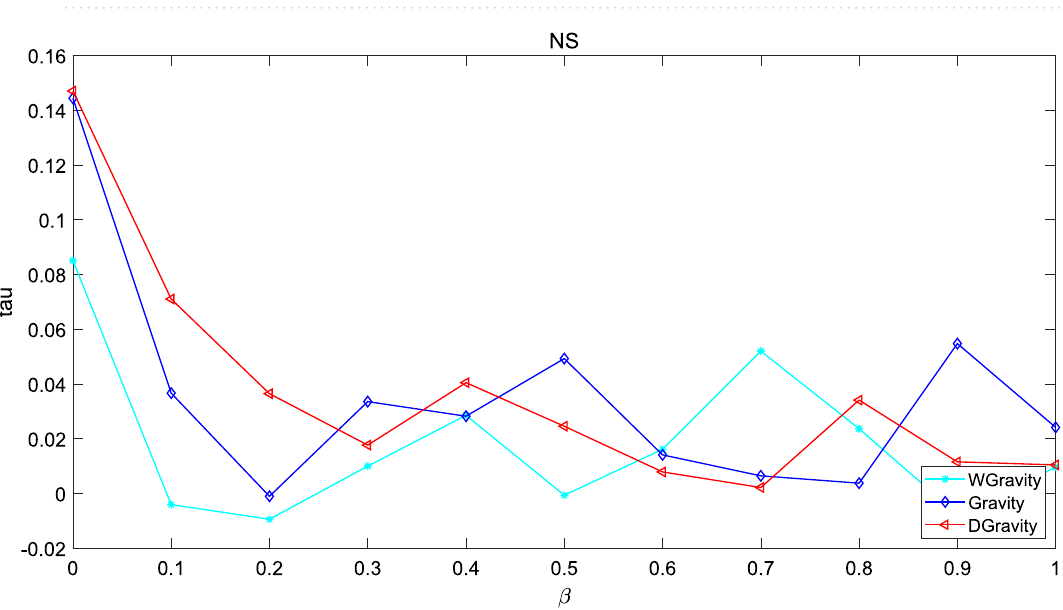
Figure 16. This figure describes the correlation between the methods based on gravity model and the standard sequence generated by SI in NS. The performance of the new model is better in the early stage, and the performance of the three methods is close to the same in the later